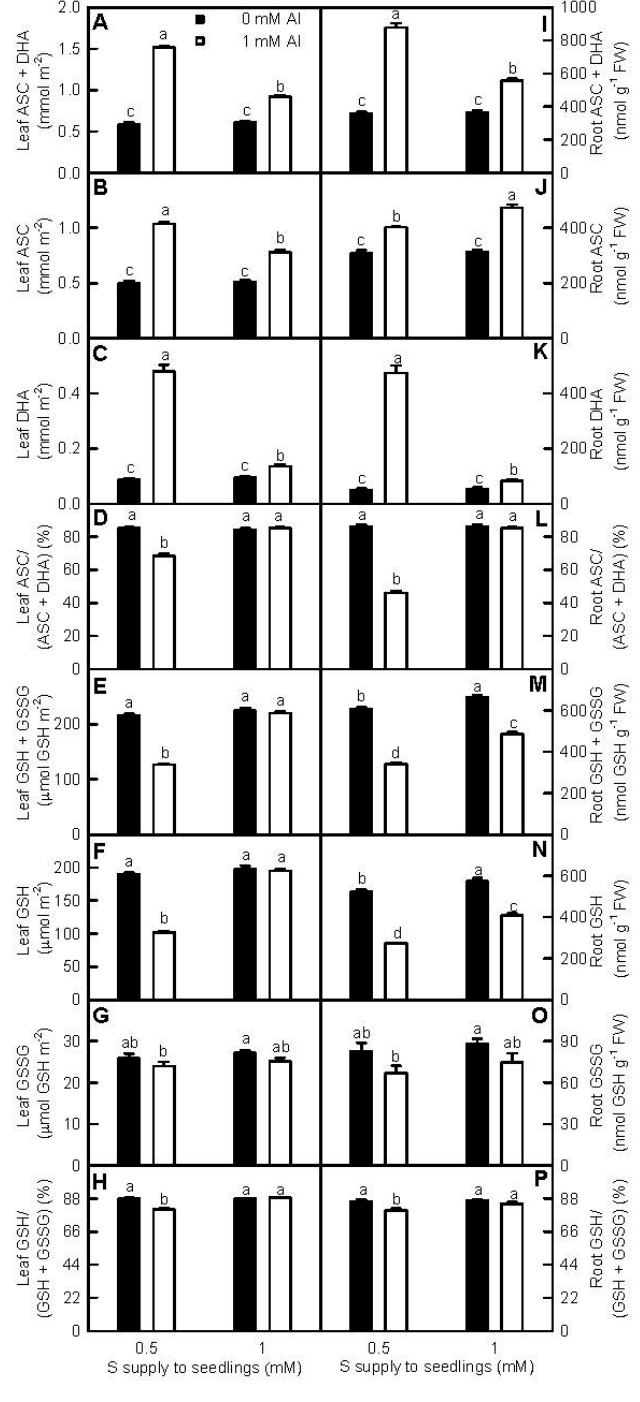
Figure 7. Effects of S and Al interactions onascorbate (ASC) +dehydroascorbate(DHA) ( A , I ), ASC ( B , J ), and DHA ( C , K ) concentrations; ASC/(ASC + DHA) ratios ( D , L ),reduced glutathione (GSH) +oxidized glutathione (GSSG) ( E , M ), GSH ( F , N ) and GSSG ( G , O ) concentrations; and GSH/(GSH + GSSG) ratios ( H , P ) in leaves ( A – H ) and roots ( I – P ). Differences among the four treatments were analyzed by two (Al levels) × two (S levels) ANOVA. Bars represent means ± SE ( n = 4). Different letters indicate a significant difference at p < 0.05.